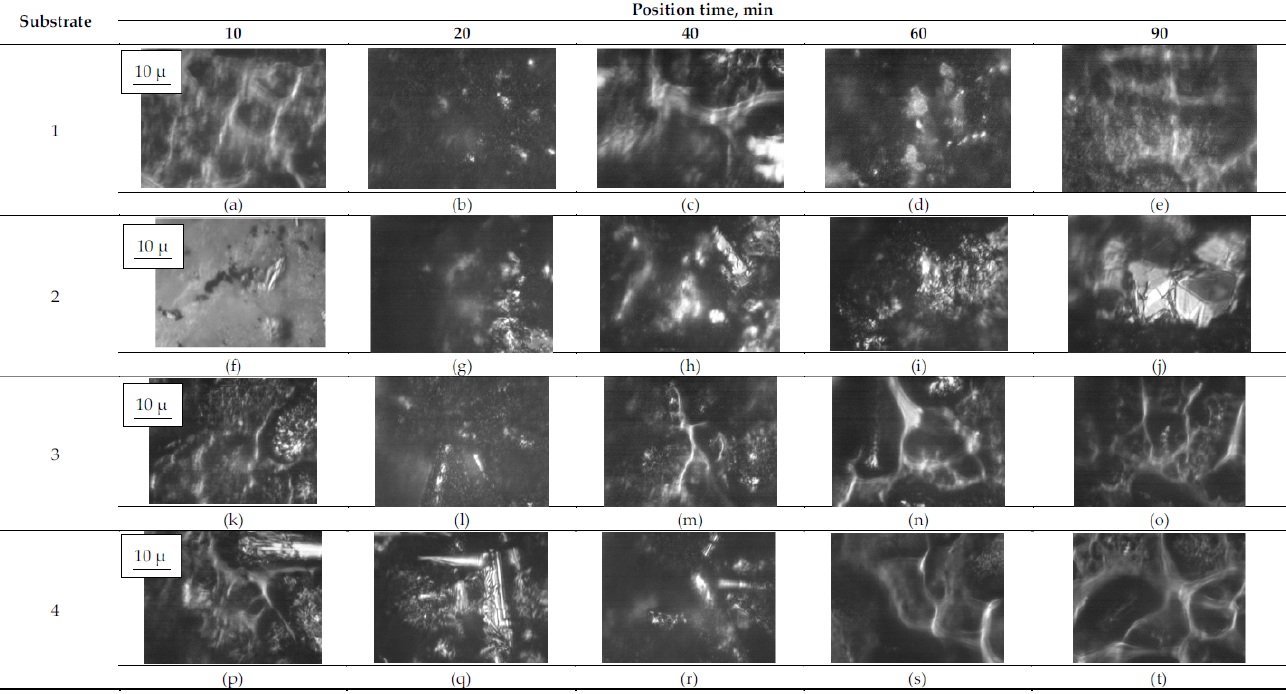
Figure 5. Optical image of vitamin B12; four types of substrates with different deposition times.